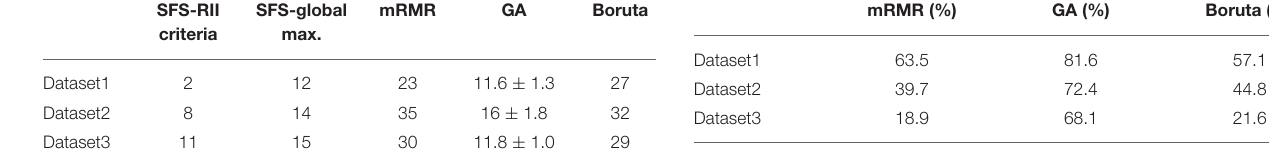
TABLE 1 | Number of features selected in LOOCV using different feature selection methods. SFS-RII SFS-global mRMR Boruta criteria max.